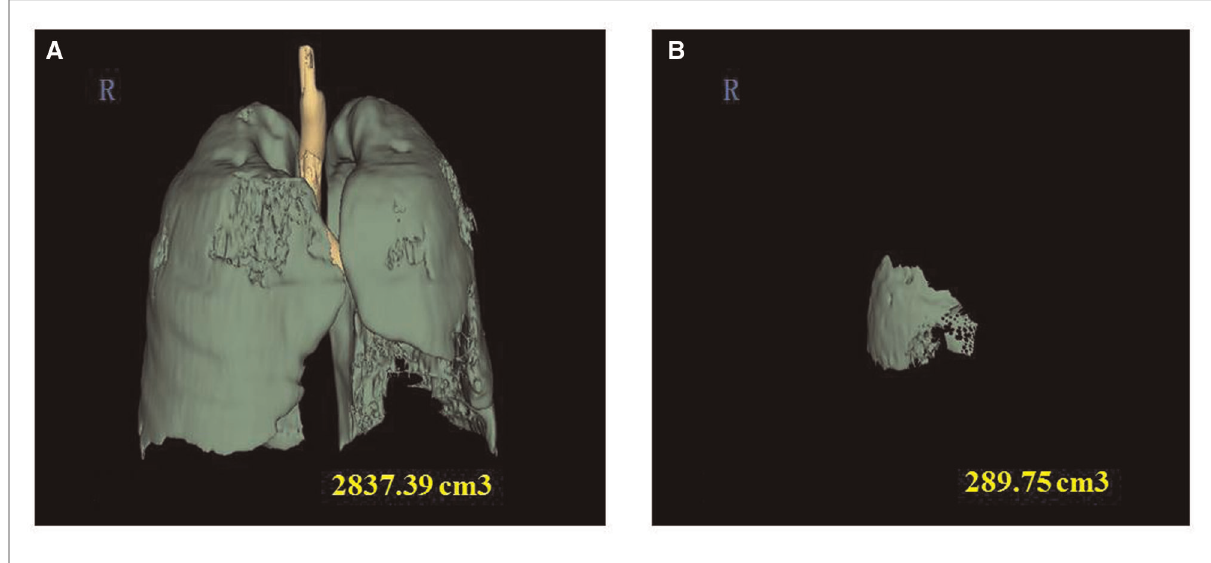
FIGURE 2 Three-dimensional reconstruction of chest CT images to calculate the volume fraction of pulmonary contusion. ( A ) Three-dimensional reconstruction of chest CT images showing the total volume of pulmonary contusion. ( B ) Three-dimensional reconstruction of chest CT images of a 61-year-old female patient showing the volume of pulmonary contusion. The volume fraction of pulmonary contusion=289.75 cm 3 / 2,837.39 cm 3